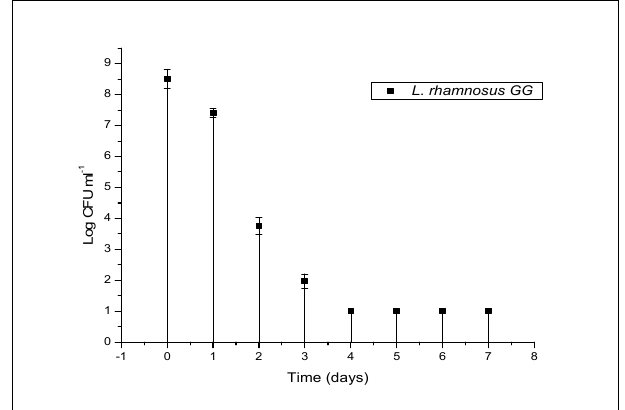
Figure 1. Viability of L. rhamnosus GG in unsupplemented sea buckthorn juice. The data presented are means of triplicate experiments ± standard deviation.